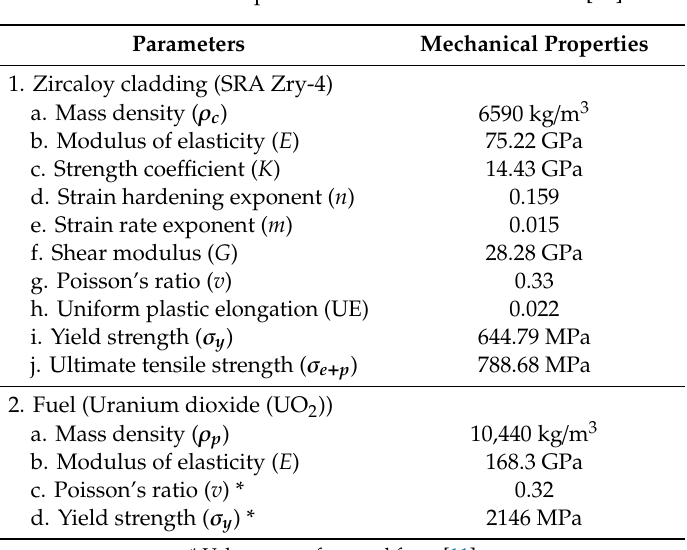
Table 3. Mechanical parameters of the fuel rod model